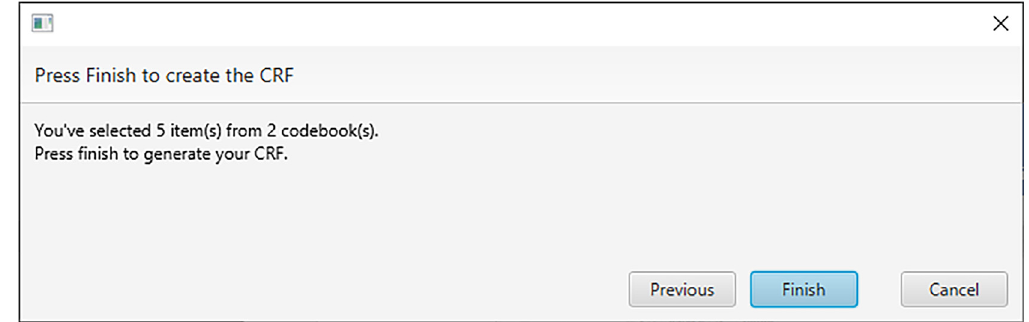
Figure 6. Summary shows number of selected